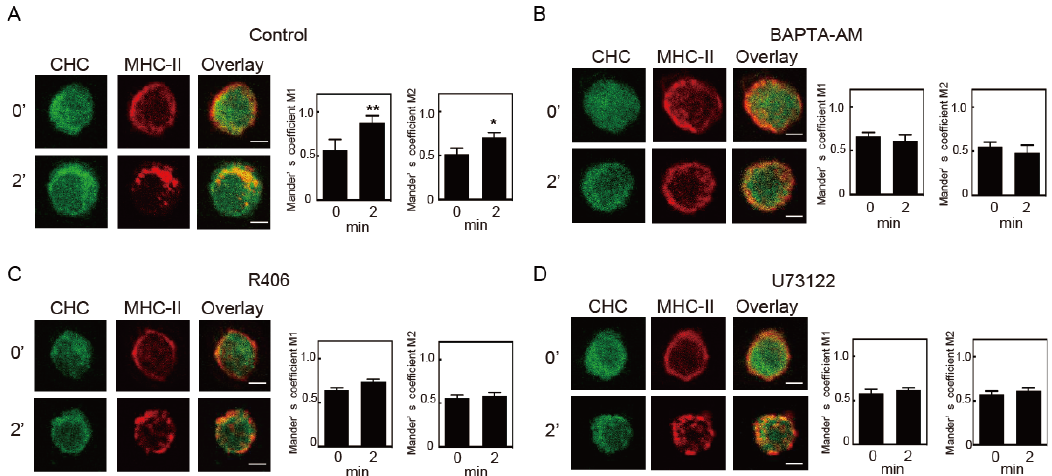
Figure 8. Effect of inhibitors on crosslinking-induced co-localization of MHC-II and clathrin. BMDCs pre-incubated with ( A ) control (0.1% DMSO), ( B ) BAPTA-AM (50 µM), ( C ) R406 (3 µM), or ( D ) U73122 (10 µM) for 30 min at 37 °C. The cell surface MHC-II was crosslinked with anti-MHC-II antibody. The co-localization of MHC-II and CHC was analyzed as described in Figure 7. Values are presented as the mean ± SEM (n = 10), * p < 0.05, ** p < 0.01.